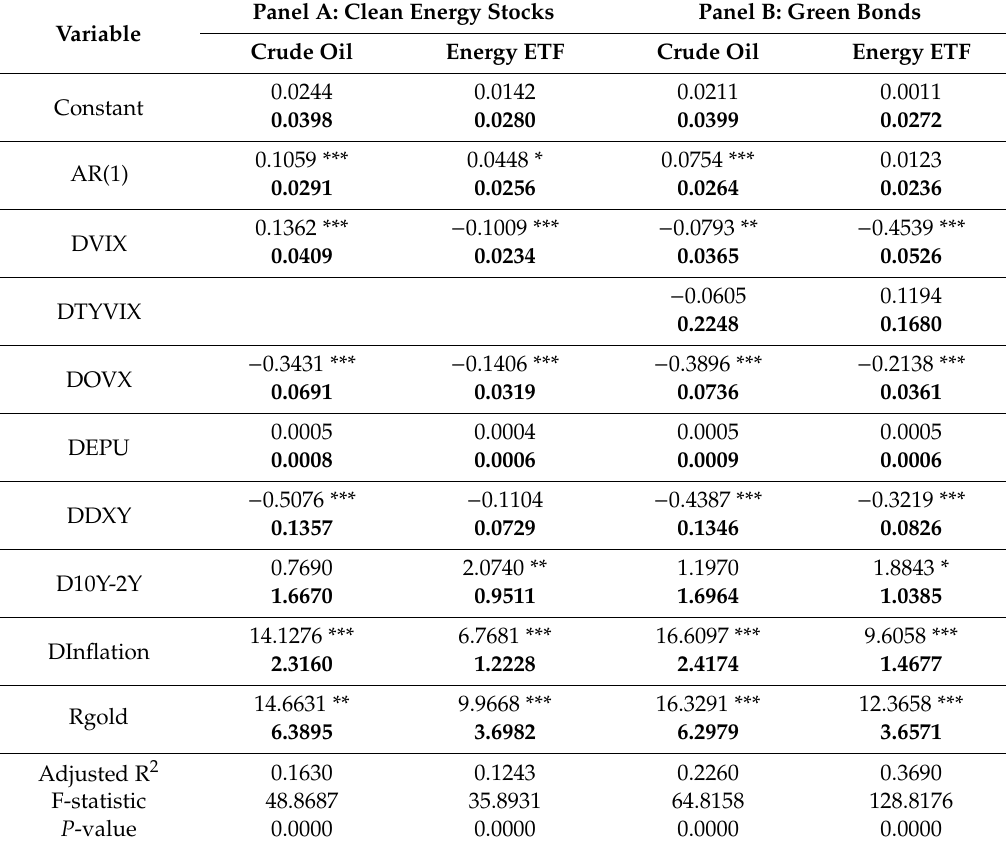
Table 7. Drivers of the hedge portfolio